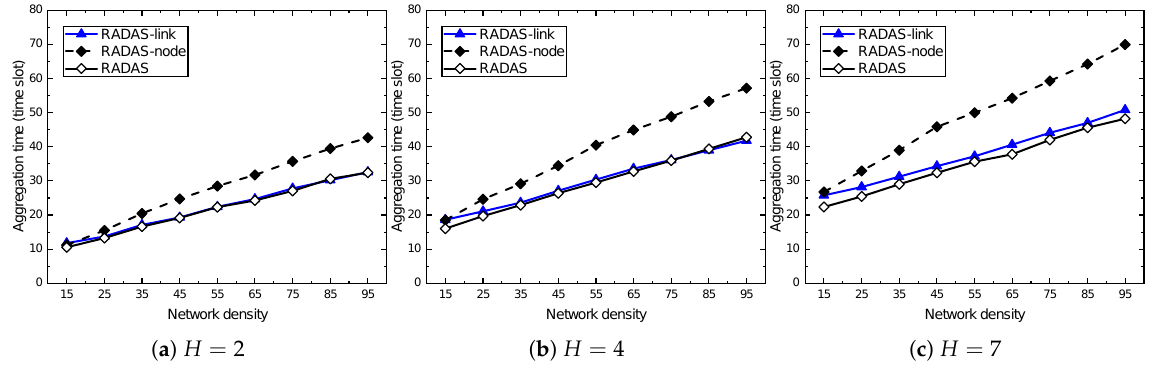
Figure 8. The impact of network density on proposed